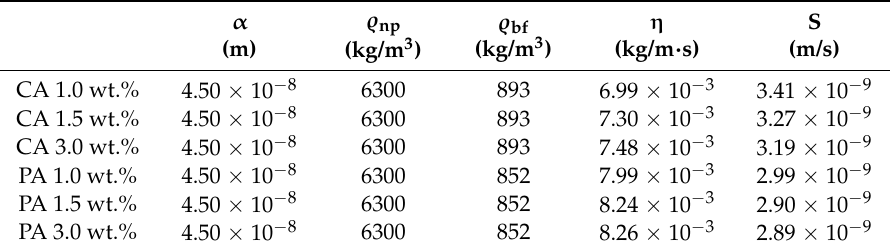
Table 1. Sedimentation velocity results.